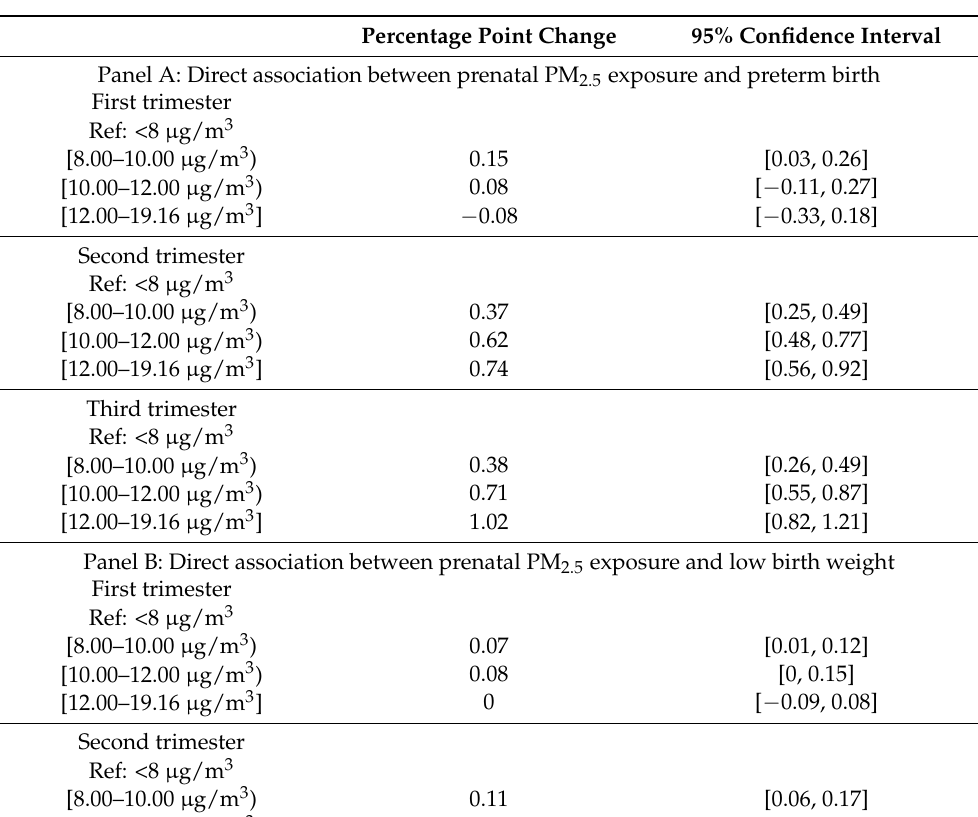
Table A6. Estimates of the association between prenatal PM 2.5 exposure, post-birth PM2.5 exposure (defined over 1 month), preterm birth, low birth weight, and infant mortality from the Structural Equation